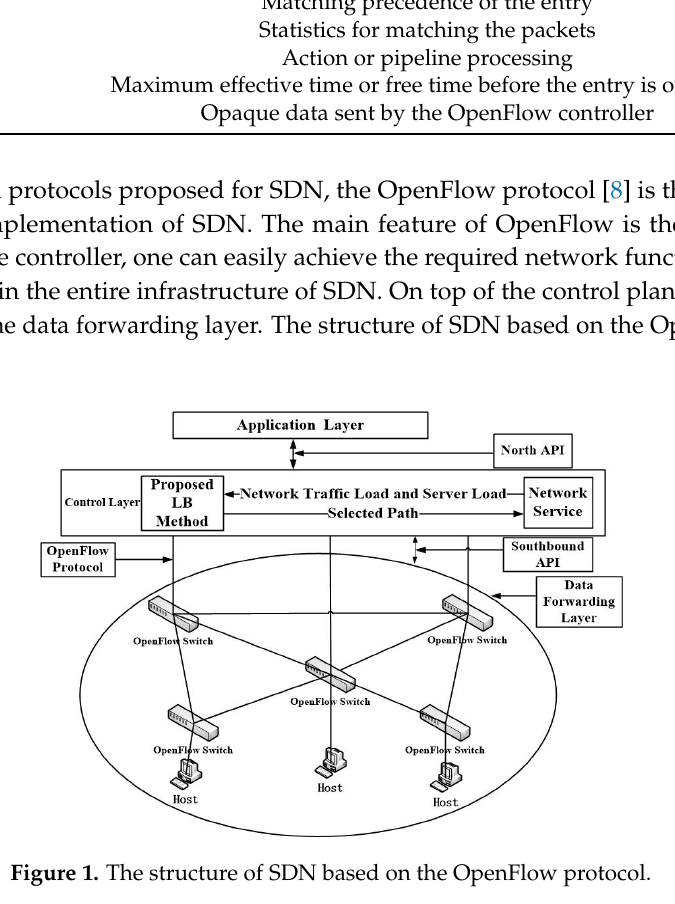
Figure 1. The structure of SDN based on the OpenFlow protocol.